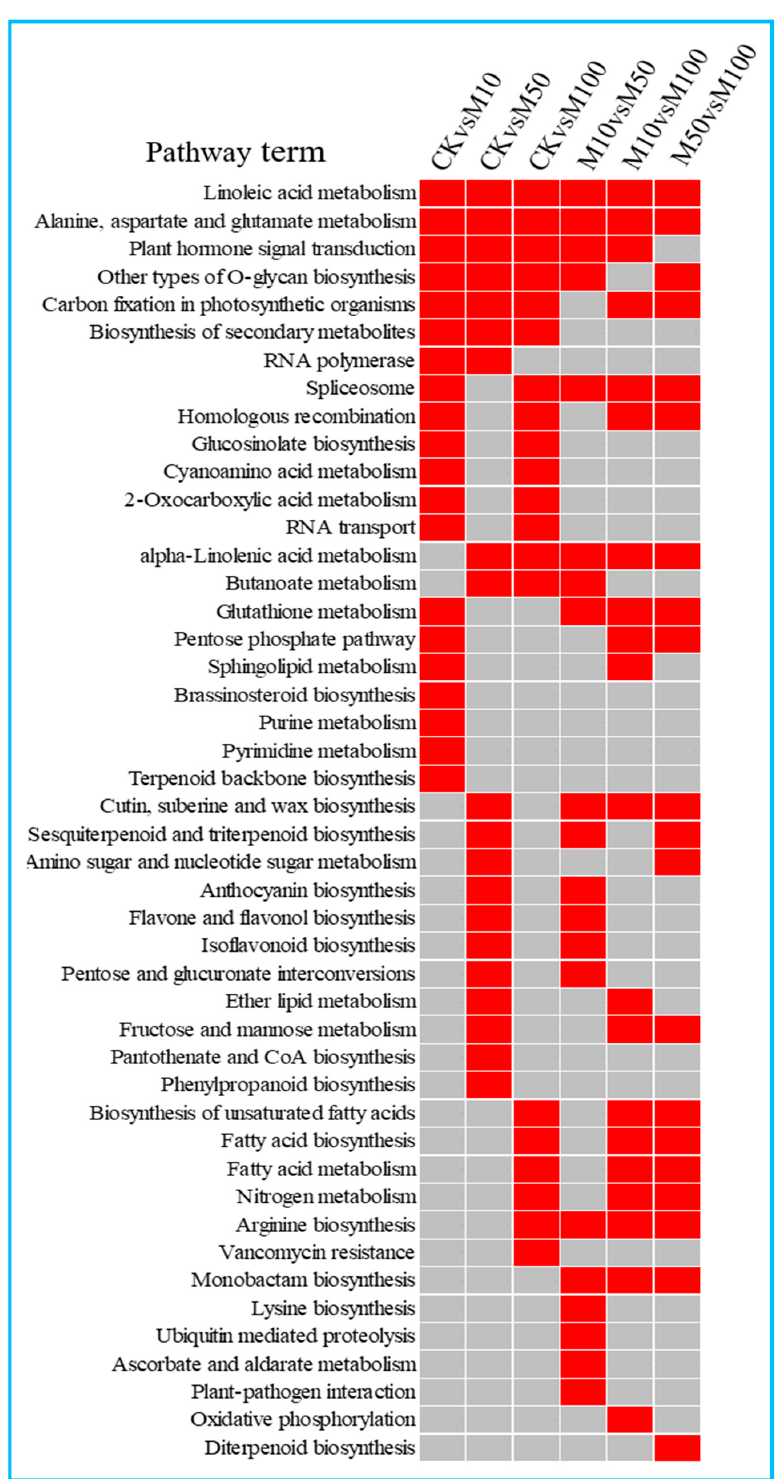
Figure 5. The top 20 KEGG pathways enriched by target genes of differentially expressed miRNAs in the six comparisons. Red indicates significant enrichment and gray indicates no significant enrichment.